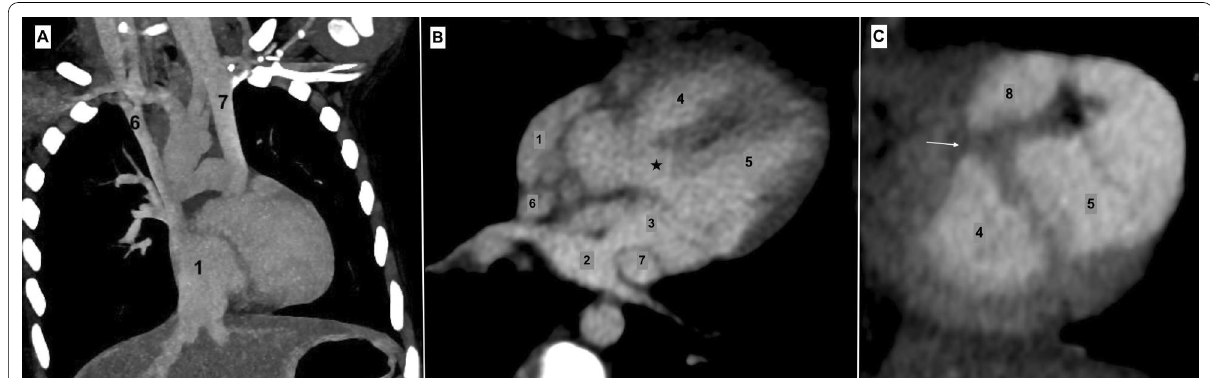
Fig. 2 CT Angiography. A Coronal section showing double SVC draining into RA. B Four-chamber view showing cor triatriatum, VSD (*) and double SVC. C Two-chamber view showing the infundibular chamber and the hypertrophied obstructing muscle bands (arrow) dividing the RV into two chambers. 1—Right atrium, 2—posterior chamber of left atrium, 3—anterior chamber of left atrium, 4—right ventricle, 5—left ventricle, 6—right superior vena cava, 7—left superior vena cava, 8—infundibular